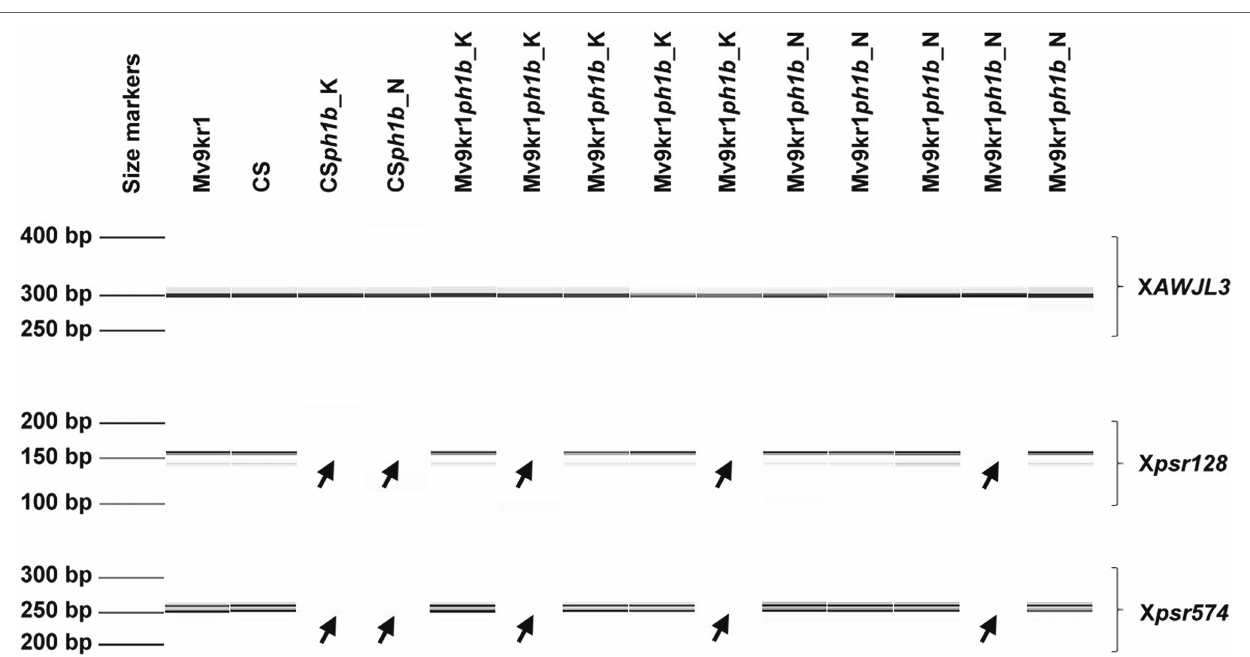
FIGURE 2 | Marker-assisted selection of Mv9kr1 ph1b mutant genotypes. On the capillary gel electrophoretogram, the presence of PCR amplicons of markers Xpsr128 and Xpsr574, which are specific for the deletion region of chromosome 5B indicate the presence of Ph1 locus in the wild type wheat genotypes CS and Mv9kr1 and some BC 1 F 1 Mv9kr1 ph1b _K and Mv9kr1 ph1b _N genotypes, while the lack of these amplicons (highlighted by arrows) indicate the presence of ph1b deletion in homozygous form in the parental CS ph1b _K and CS ph1b _N genotypes and in several depicted BC 1 F 1 genotypes. The marker XAWJL3 , which mapped to chromosome 2A was used as positive control for the PCR assay.